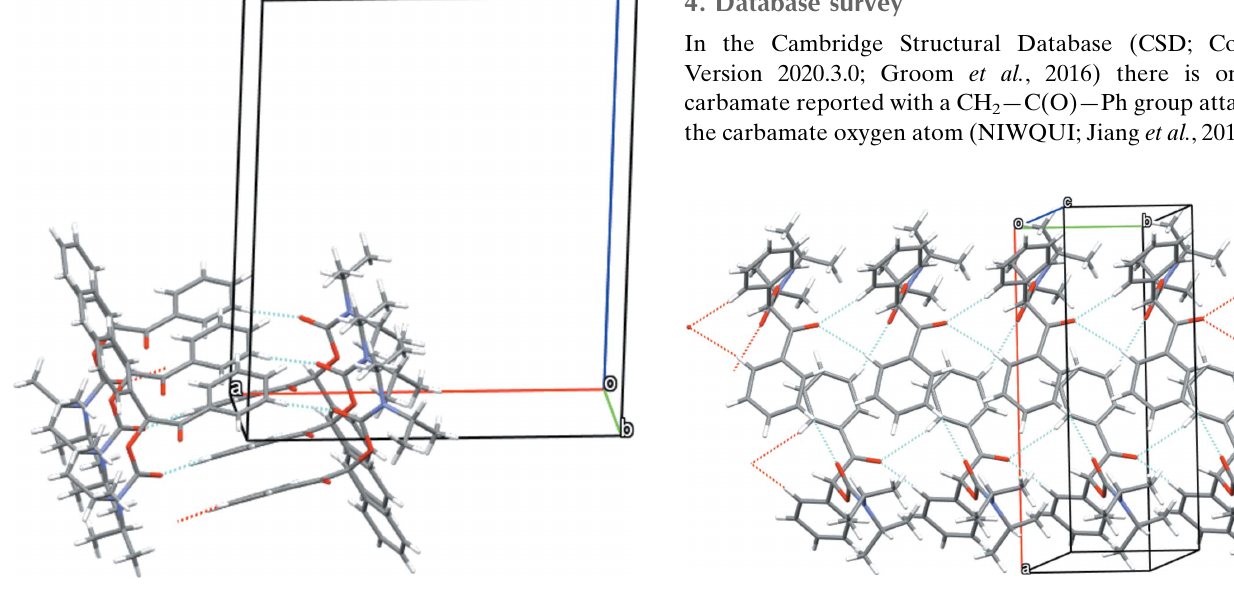
Figure 3 Crystal structure of the R -enantiomer of the title compound showing the helical arrangement of molecules parallel to the b axis built up by C— H (cid:2)(cid:2)(cid:2) O hydrogen bonds.